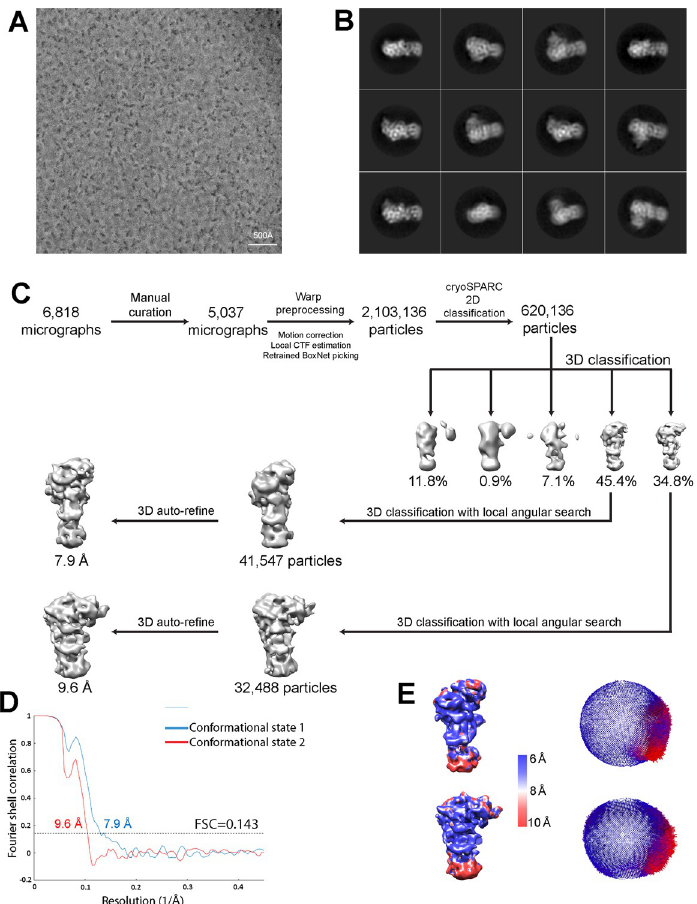
Fig 2. Image processing procedures. ( A ) Representative micrograph. A total of 6,818 micrographs were collected and processed. ( B ) Representative 2D class averages from RELION reference-free 2D classifications. ( C ) Data processing workflow for cryo-EM map reconstruction. ( D ) FSC curves for the two conformations observed, resulting from gold standard 3D refinement. Resolution was determined with a 0.143 FSC threshold. ( E ) Local resolution estimated by Monores and angular distribution analyzed from RELION. Most parts of the two conformational EM structures are resolved in the resolution range of 6–10 Å .